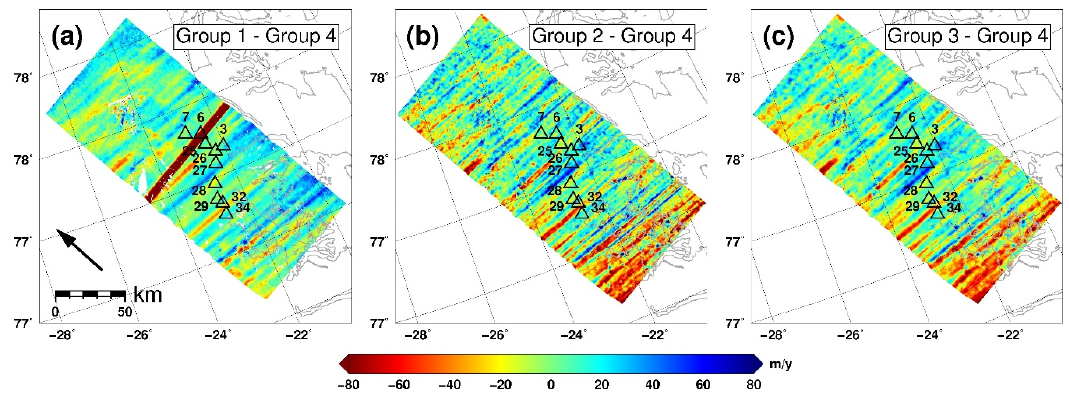
Figure 8. Azimuth velocity differences between groups 1 to 3 with respect to group 4.